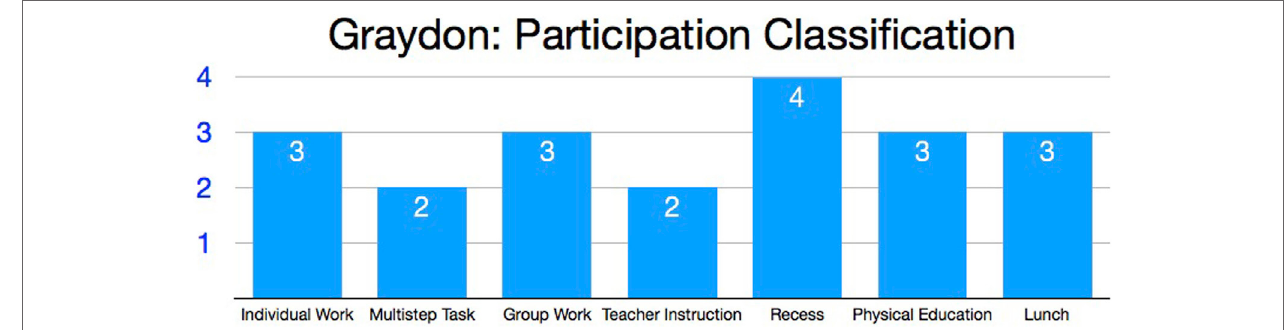
FigUre 1 | “Graydon”: classification of participation levels for activities in the school environment.